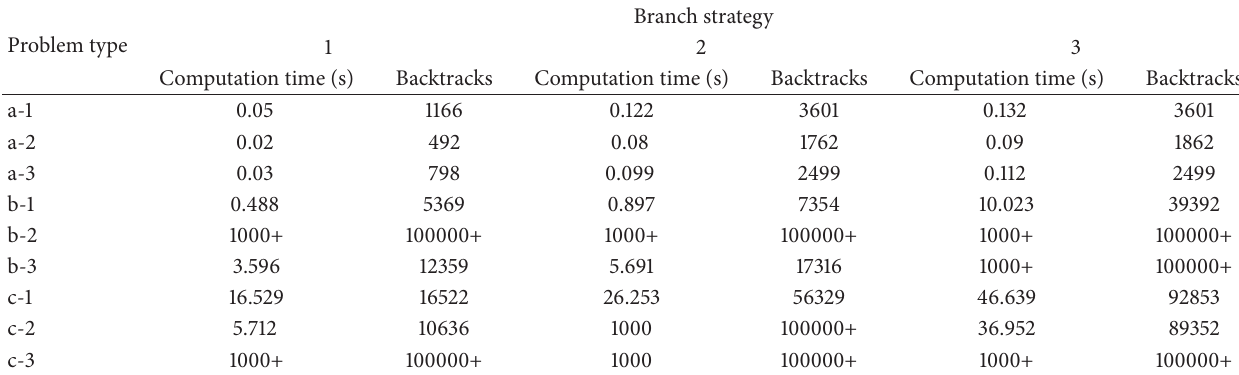
Table 4: Comparison of the search results of three branching